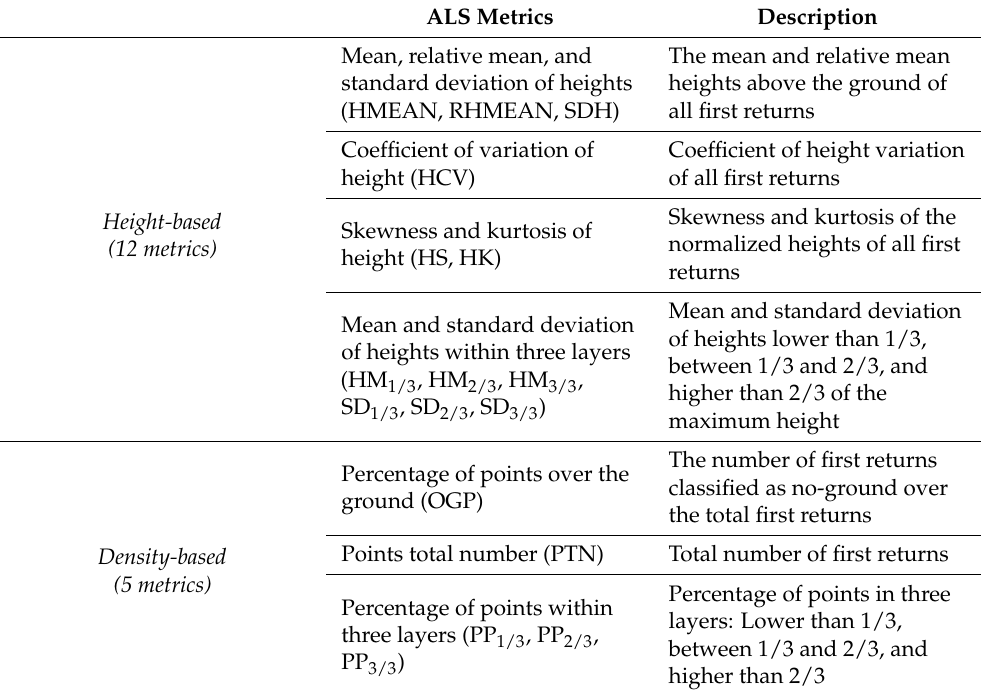
Table 1. Definition of ALS metrics. Note: To compare ALS and TLS, ALS metrics that consider the space divided into thirds (HM1, HM2, HM3, SD1, SD2, SD3, PP1, PP2, PP3) were computed up to a height of 22